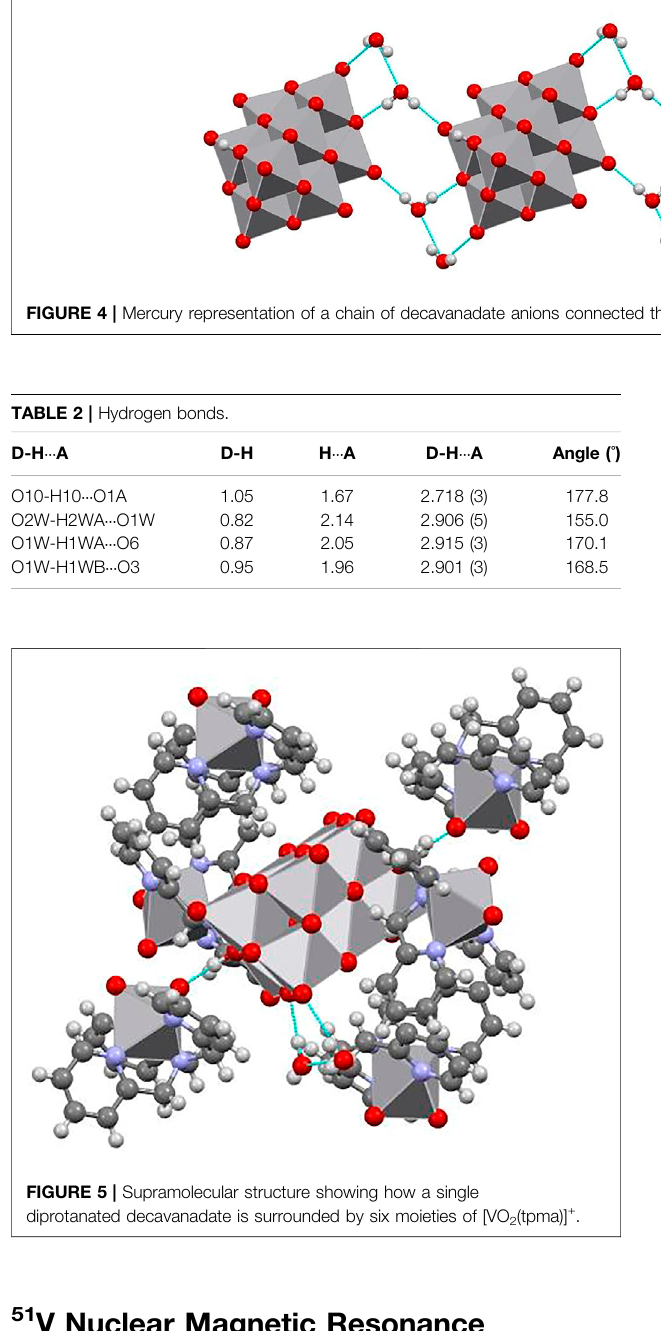
Frontiers in Chemistry |